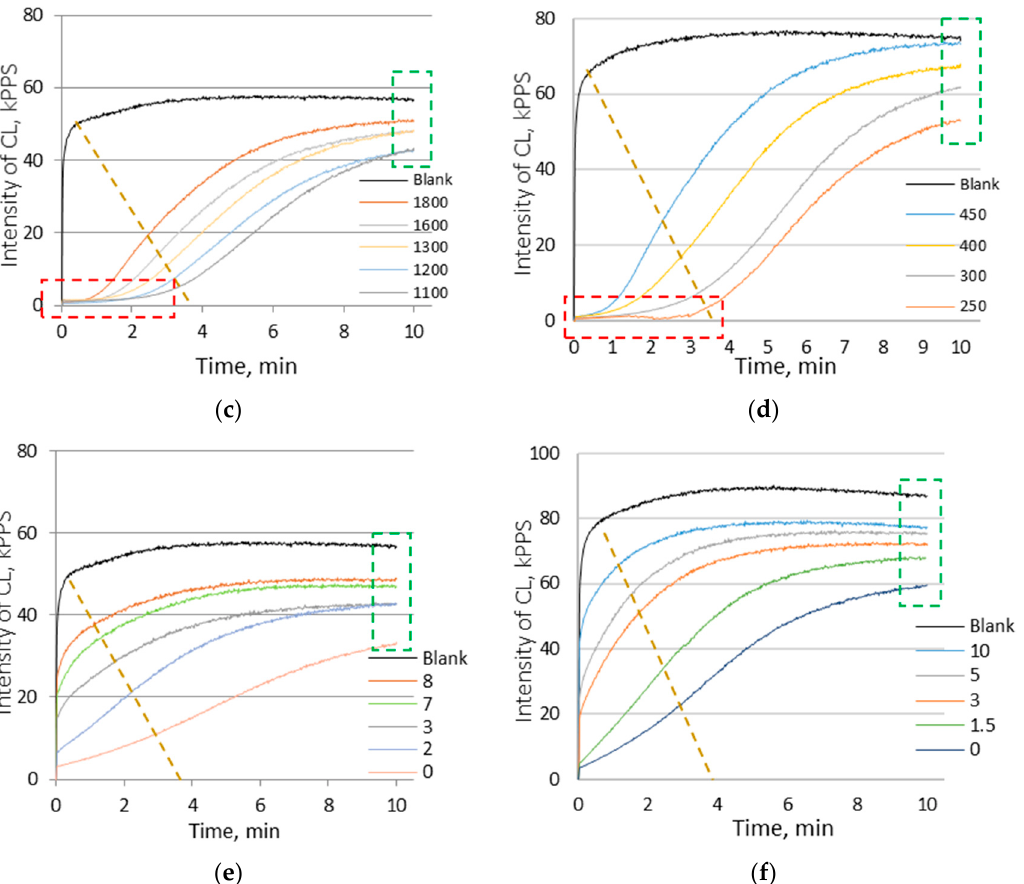
Figure 3. Effect of onion husk extracts on chemiluminescence kinetics: ( a ) ethanolic extract from yellow onion; ( b ) water extract from yellow onion; ( c ) ethanolic extract from red onion; ( d ) water extract from red onion; ( e ) ethanolic extract from white onion; ( f ) water extract from white onion. Different colors correspond to various dilutions.